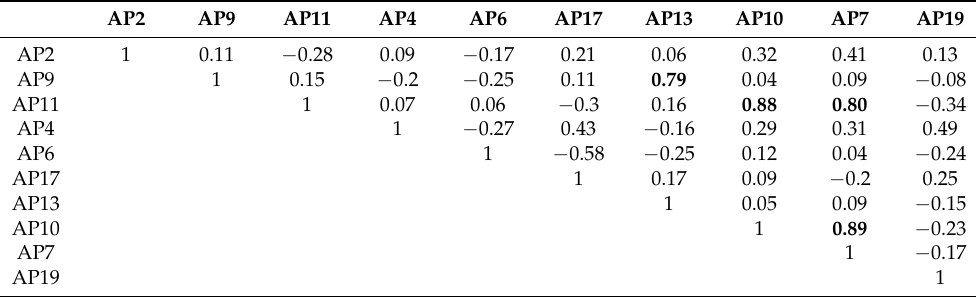
Table 4. Pearson correlation coefficients of different APs at reference Location 1.